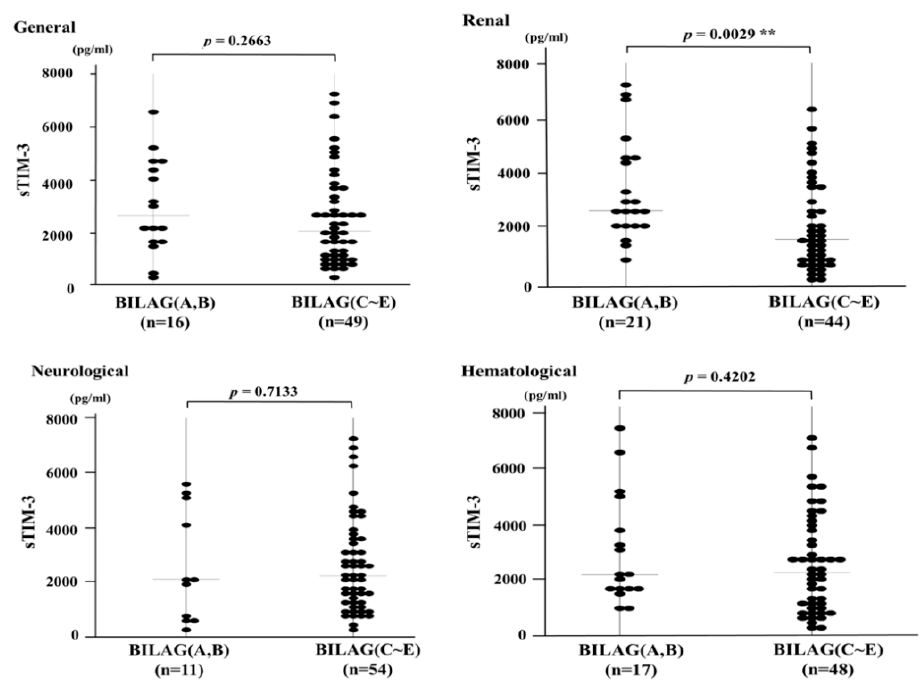
Figure 3. Serum sTIM-3 levels in patients SLE (systemic lupus erythematosus) patients with or without active organ involvement. Comparison of serum sTIM-3 levels between SLE patients with active organ involvement (BILAG general, renal, neurological, and hematological indexes A–B) and without active organ involvements (BILAG index C–E). BILAG: British Isles lupus assessment Group, sTIM-3: soluble T cell immunoglobulin and mucin-domain-containing molecule 3. **, p < 0.01 is considered as statistically